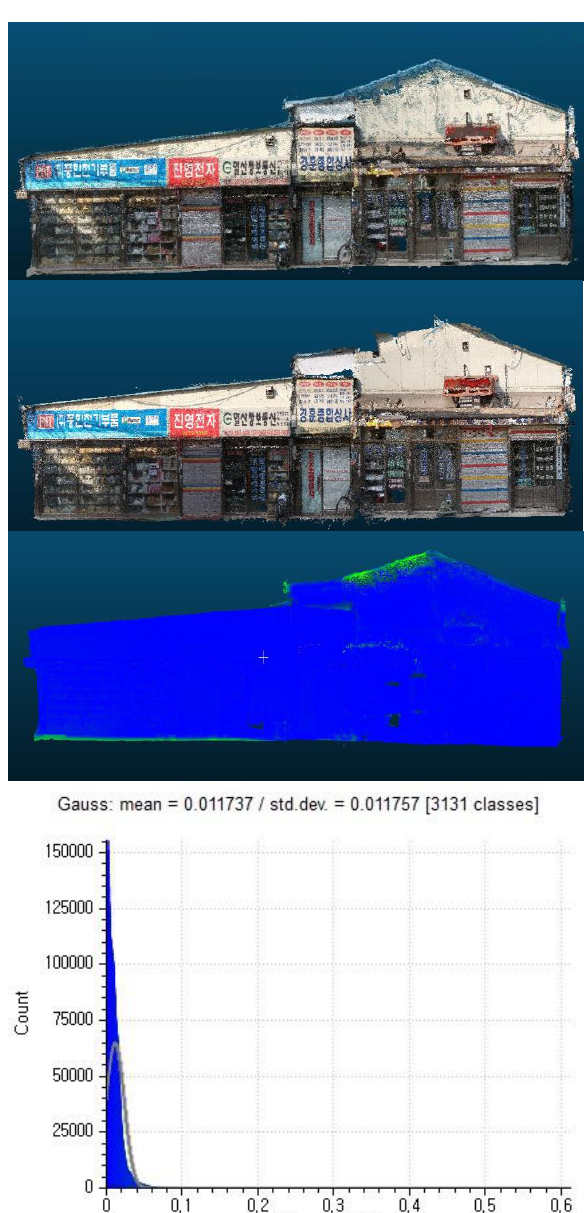
As a result of georeferencing action camera images using the control points, the easting, northing, altitude RMSE of the control points were 0.006m, 0.007m, 0.017m, respectively, and